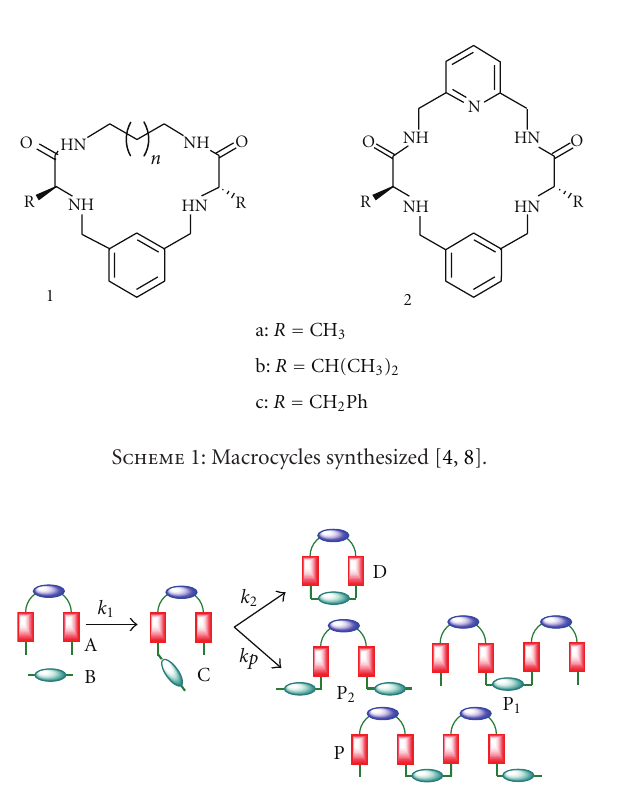
Scheme 2: General representation of the di ff erent competing processes in the macrocyclization under